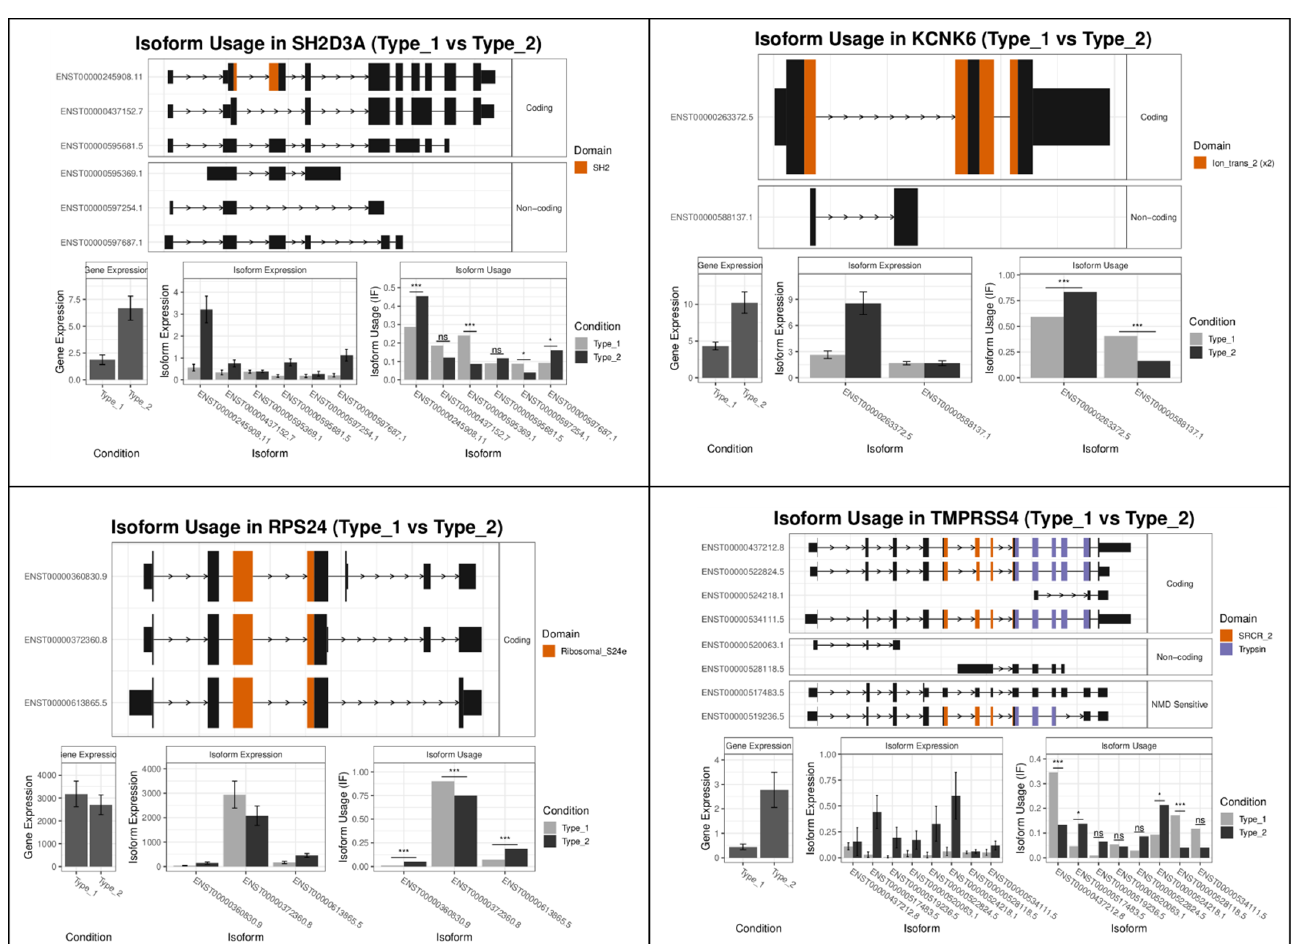
Figure 3. Top spliced genes in type 1 compared to type 2 lesions. A set of 80 melanoma and benign melanocytic nevus samples was analyzed by RNA-seq technology after laser microdissection of malignant cells. Differential gene expression analysis was performed as described in the Materials and Methods section. For the identification of differentially expressed splice variants, the kallisto program was used. Splice variants of the four top genes are shown. *, p < 0.05; ***, p < 0.001, n.s., not significant.